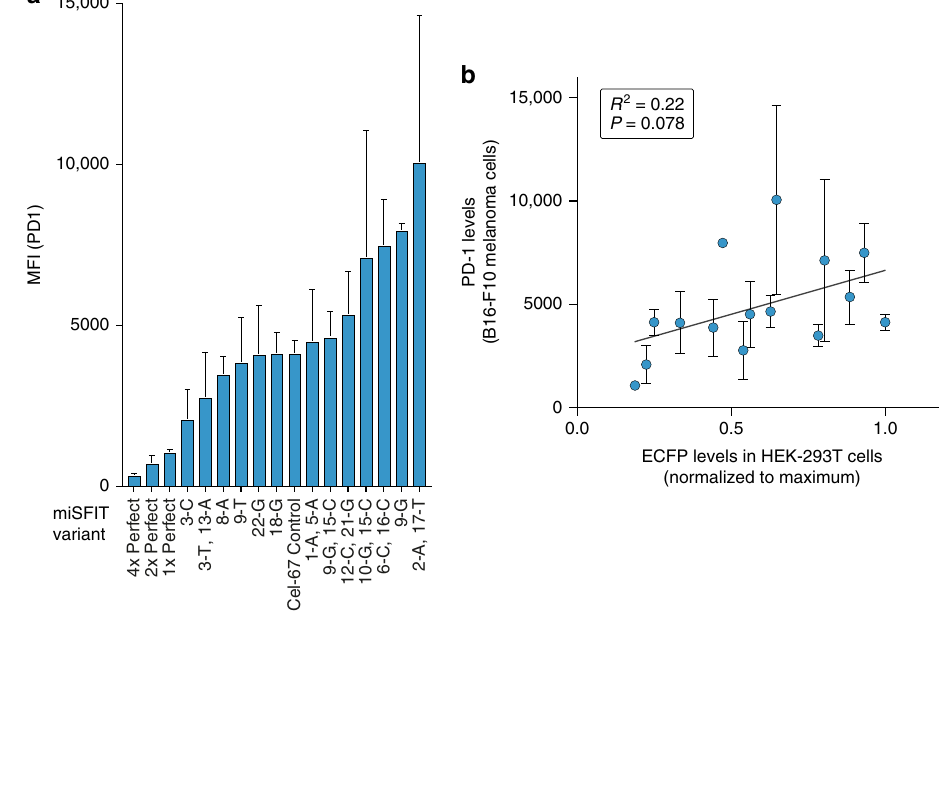
ECFP levels in HEK-293T cells (normalized to